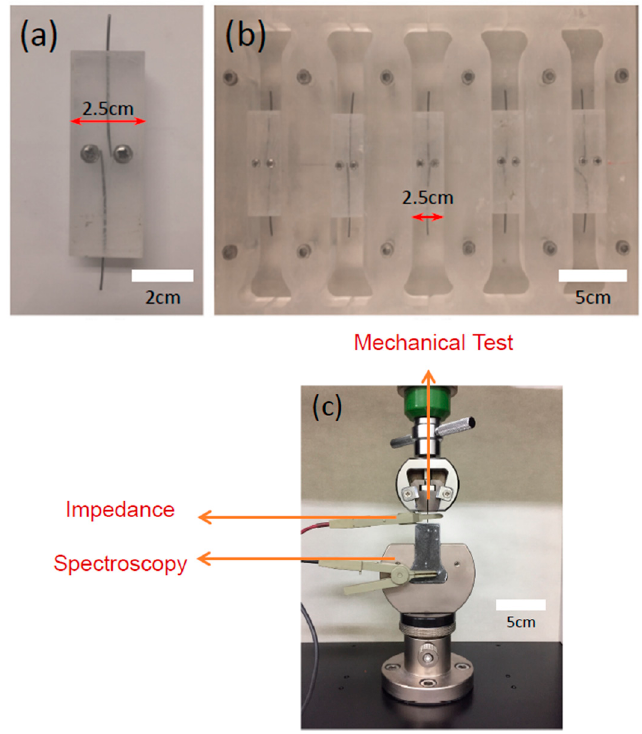
Figure 1. Molds for pullout specimens: ( a ) device for holding Ni/Ti shape memory alloy (SMA) fibers and ( b ) mold employed for pullout specimens inserted with the Ni/Ti SMA fibers. ( c ) Image showing the measurement environment allowing for simultaneous mechanical and electrical characterization.